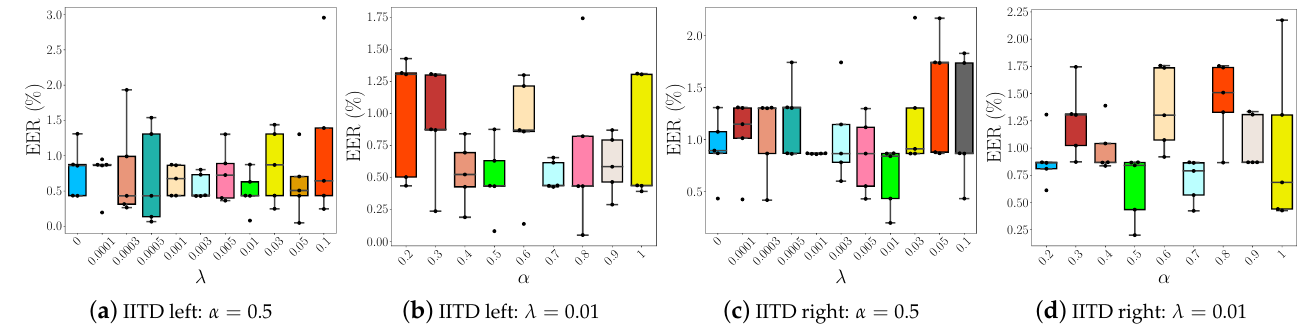
Figure 10. Results of the sensitivity analysis in the form of box plots of the generated EER scores. The Two-path CNN model is trained with different combinations of λ and α parameters on: ( a ) IITD left, ( b ) IITD right, ( c ) CASIA left and ( d ) CASIA right palmprints, respectively. The figure is best viewed in